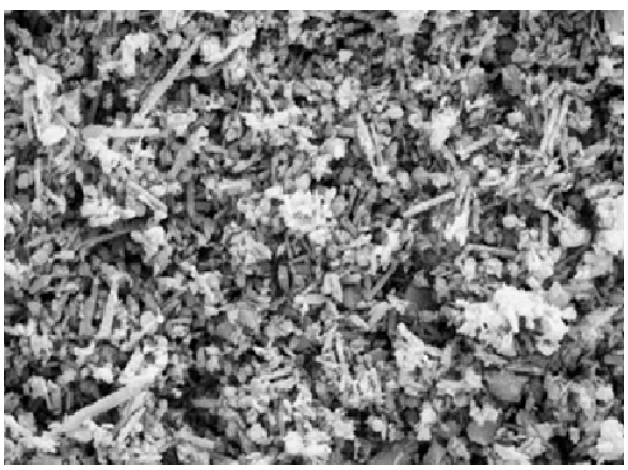
Figure 4. Morphological characterization of combustion residue of modified ‘HNT-based nanocomposites’ with 10-per hundred rubber (phr) loading [9].